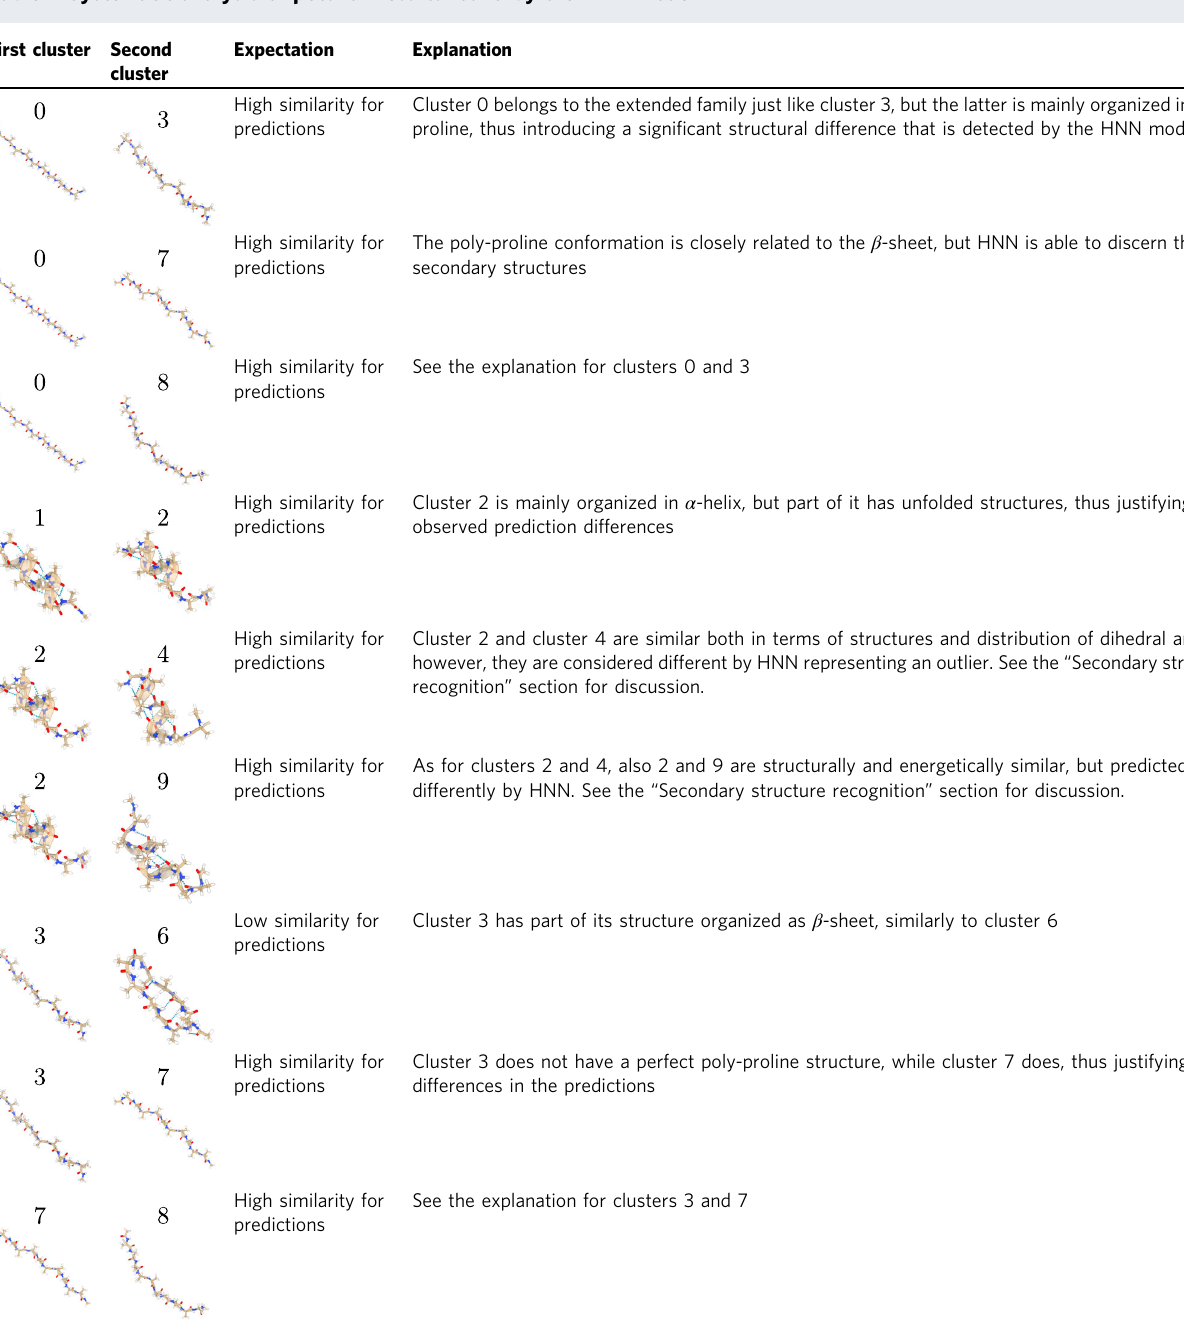
Table 2 Systematic analysis of peculiar results found by the HNN